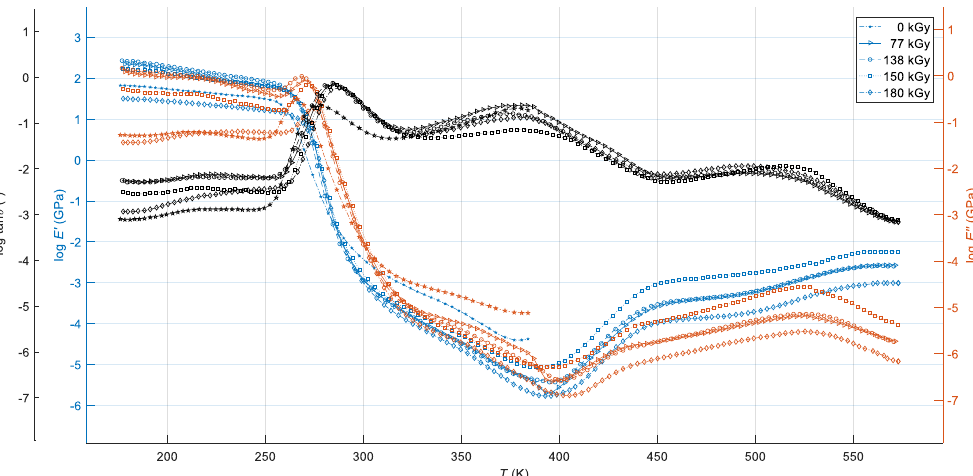
Figure 2. Dynamic mechanical response of PMX3 resin-rubber blend for various radiation doses as a function of temperature in a logarithmic scale.